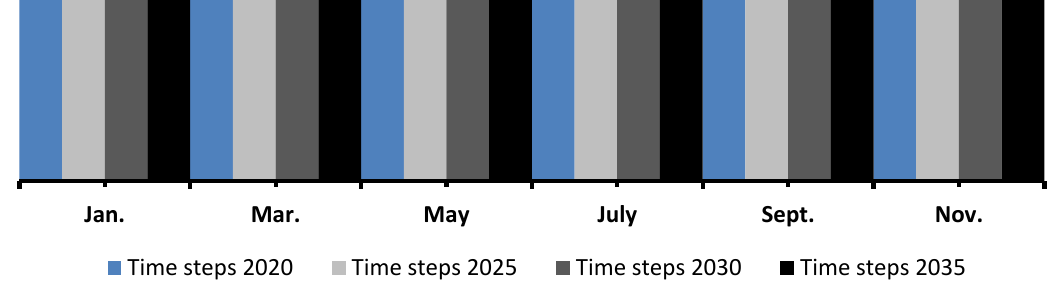
Figure 4. Time-step selection for the optimization years (2020, 2025, 2030, and 2035). Every section includes 2190 time-steps and is used for one year of the